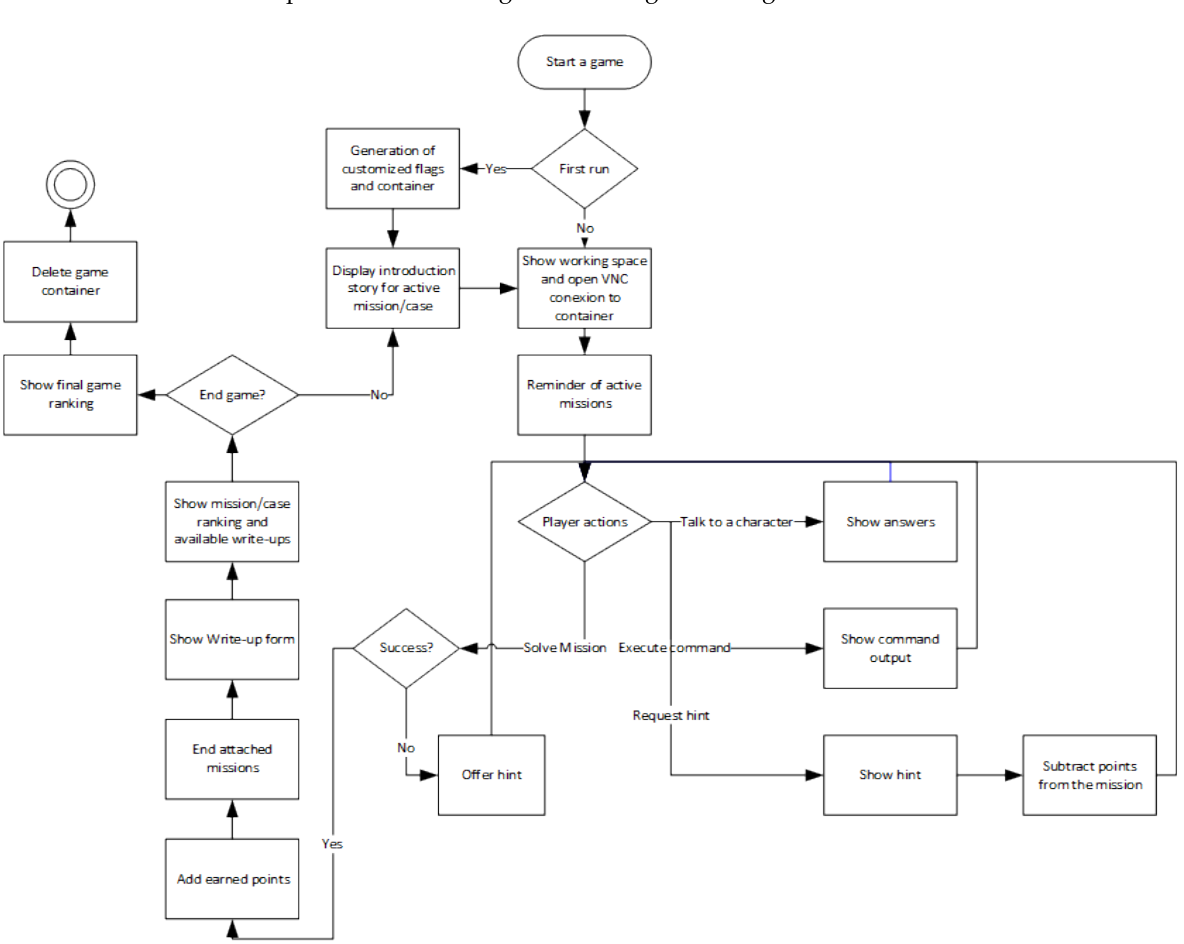
Figure 5. Schematic representation of the game flow. (cid:13) is the start of the game. (cid:125) is the end of the